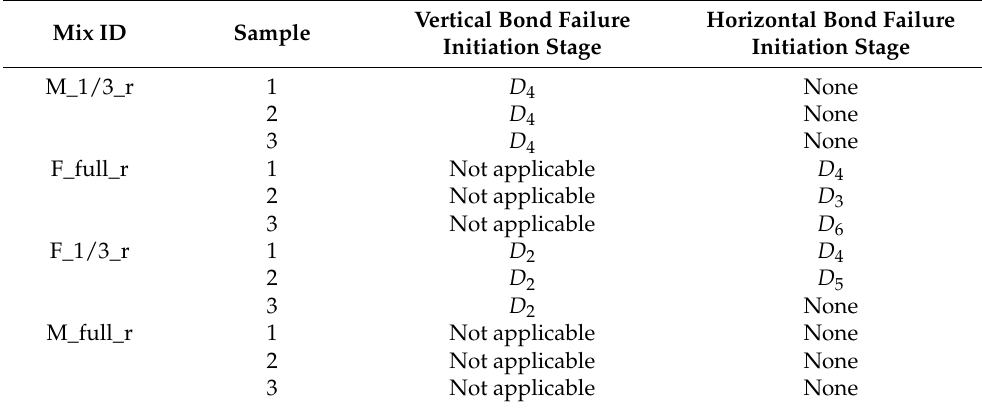
Table 4. Summary of damage levels at which vertical and horizontal bond failure started.